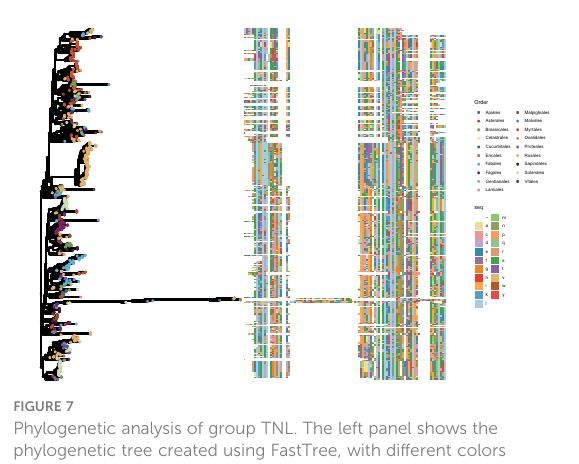
FIGURE 7 Phylogenetic analysis of group TNL. The left panel shows the phylogenetic tree created using FastTree, with different colors denoting different orders. The right panel shows the corresponding aligned domain sequences, with different colors corresponding to different amino